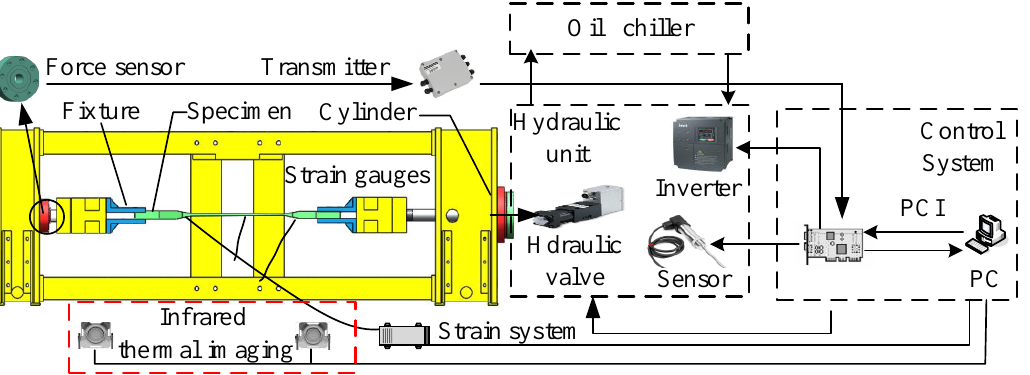
Figure 4. Displacement analysis cloud diagram of testing machine parts.